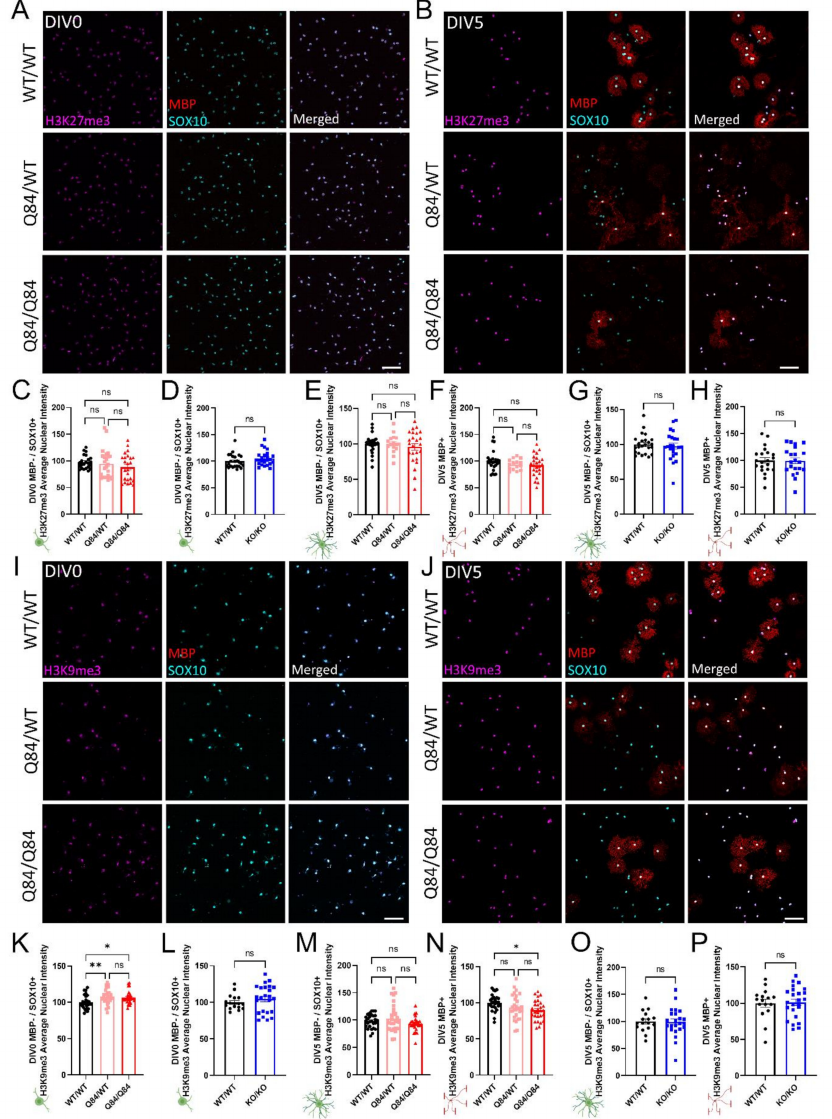
Figure 5. ATXN3 toxic gain-of-function in SCA3 oligodendrocytes leads to maturation-state depen- dent changes in the tri-methylation of H3K9, but not H3K27. ( A , B ) Representative